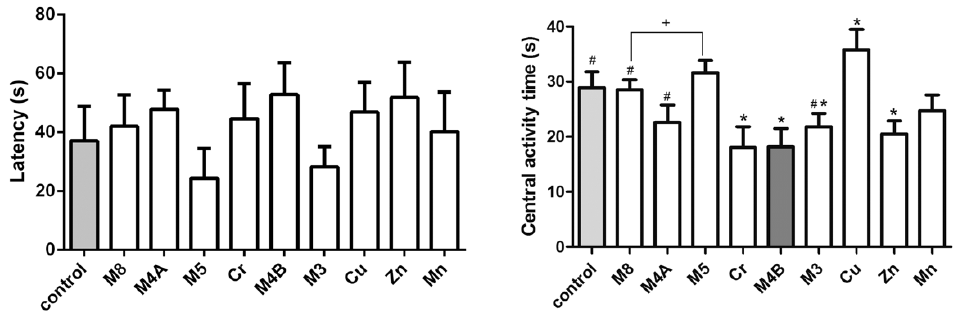
Figure 2. The latency of rats detected by the Morris water maze (MWM) test. * p < 0.05, vs. the control group; # p < 0.05 vs. the M4B group; + p < 0.05, M8 group vs. M5 group. Abbreviations: Con, control group; M8: the mixture of eight common metals (Pb + Cd + Hg + Cu + Zn + Mn + Cr + Ni); M5: